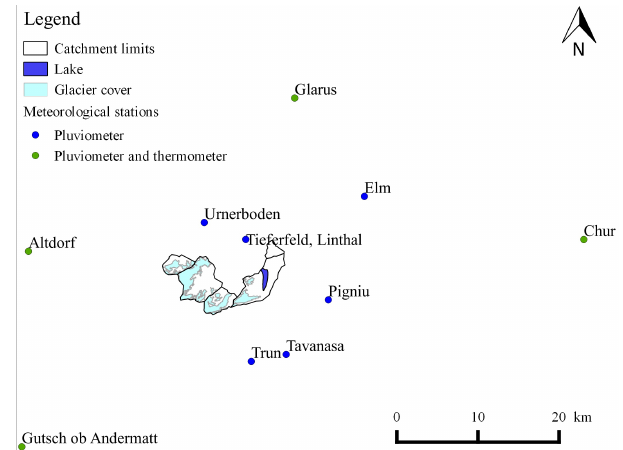
Figure 2. Situation of the meteorological stations around the Lim- mernboden catchment used for the calibration and validation of the hydrological